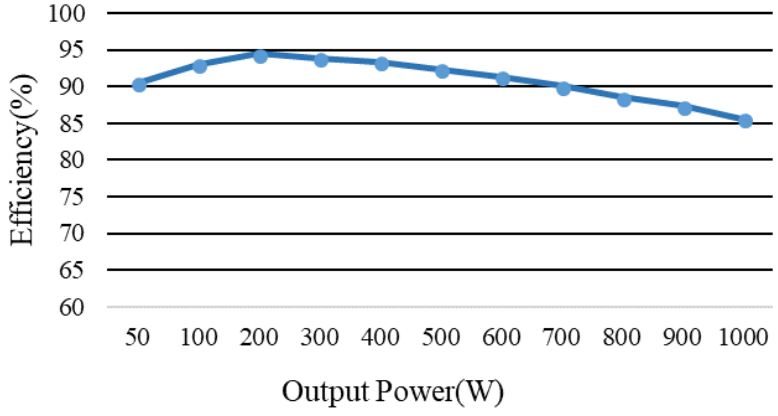
Figure 17. Experimental conversion efficiency of the implemented converter.